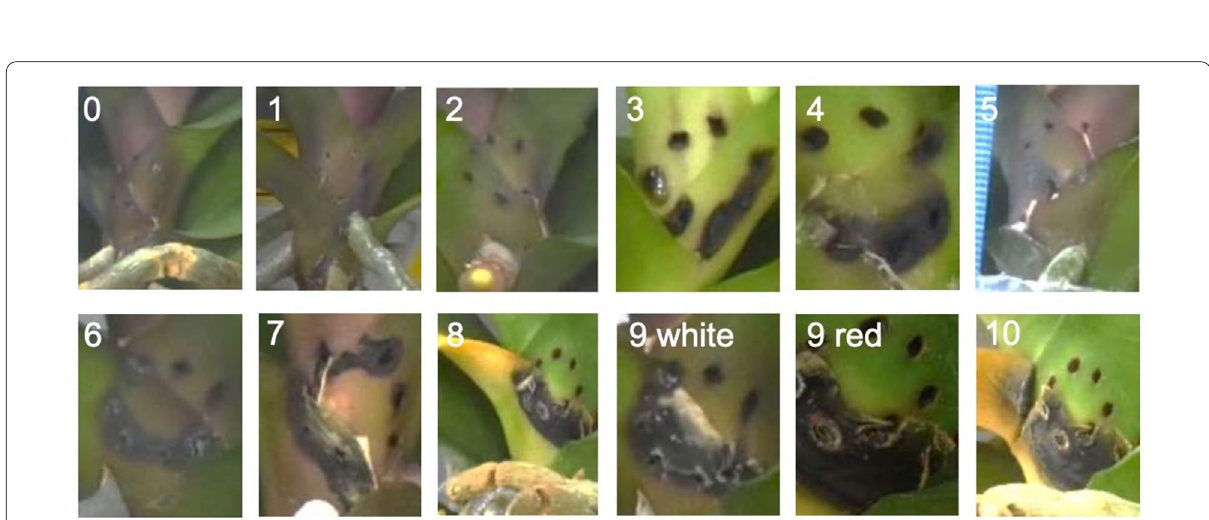
Fig. 2 Severity rank of abbreviated stem. (0): No black holes; (1) Number of black holes less than 3; (2 )Number of black holes between 4–7; (3) Black holes connected together; (4) Black spread outside of the wound; (5) Less than 3 holes filled by hypha; (6) Number of holes filled by hypha between 4 to 7; (7) A region of white area showed; (8) Yellow symptom showed; (9) White / Red spots appeared; (10) Yellow leaf